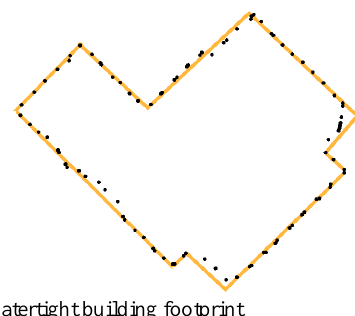
Figure 6. Watertight building footprint